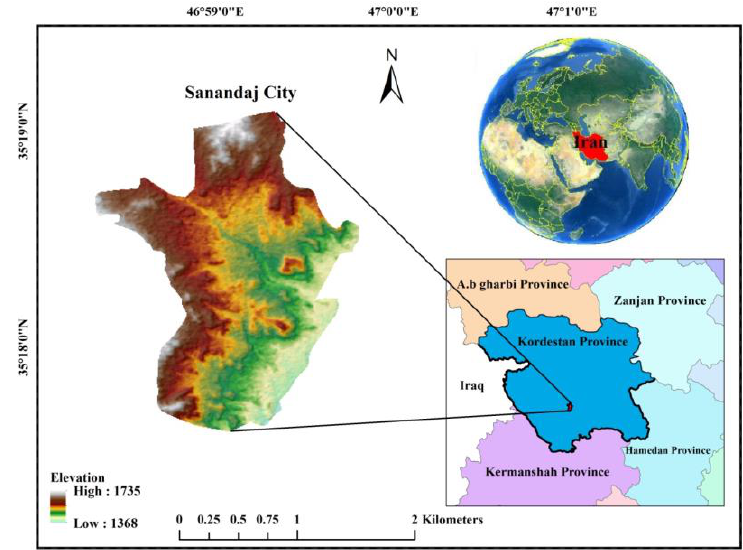
Figure 1. Location of study